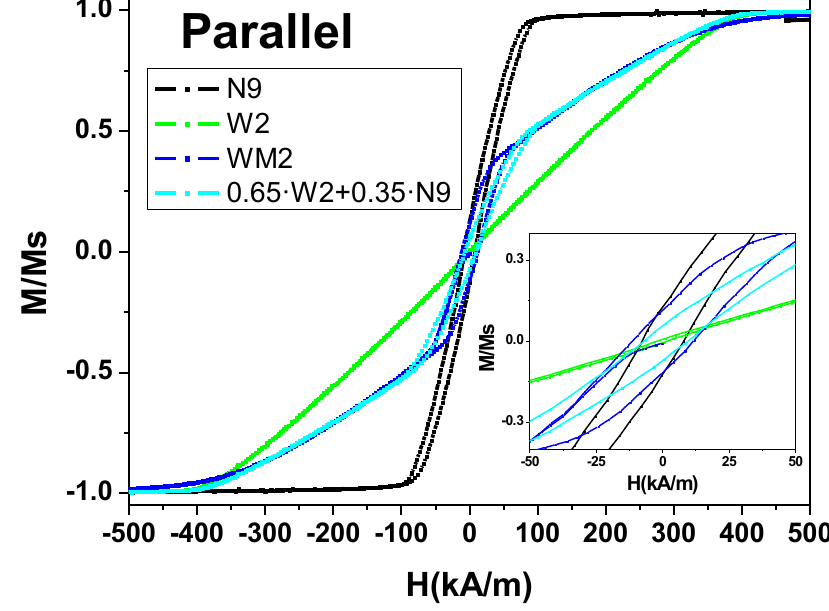
Figure 6. VSM parallel hysteresis loops of nanowire arrays containing narrow segments (N9-black), wide segments (W2-green), narrow and wide segments (WM2-blue), and the weighted average of normalized hysteresis loops of single segment arrays (0.65W2+0.35N9-cyan).